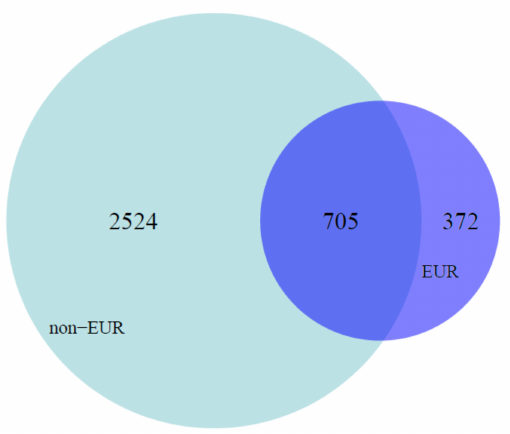
Figure 1. Venn diagram of 1000 Genomes Project Phase 3 pharmacogene